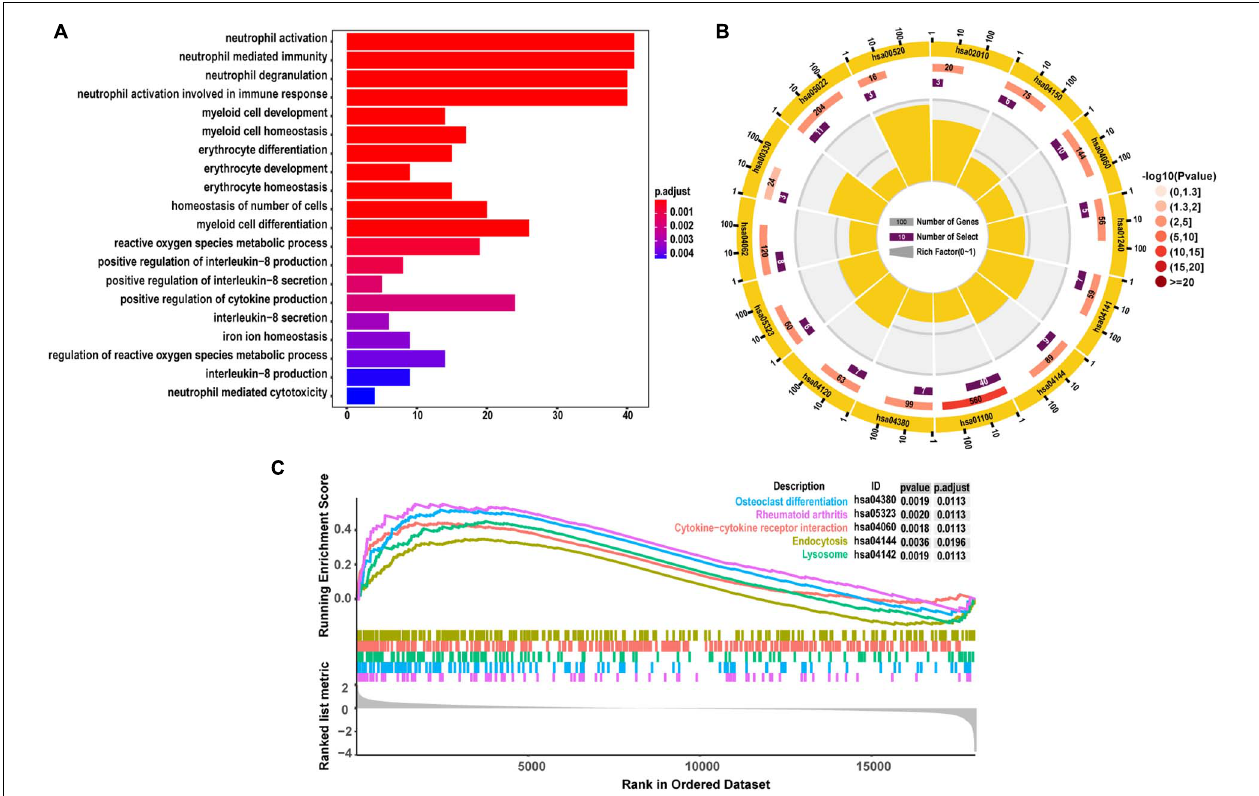
FIGURE 3 | The results of functional enrichment analyses. (A) GO analyses results of DEGs; (B) pathway analyses results of DEGs; (C) the top 5 signal pathways were most related to the pathology of SONFH from the of results